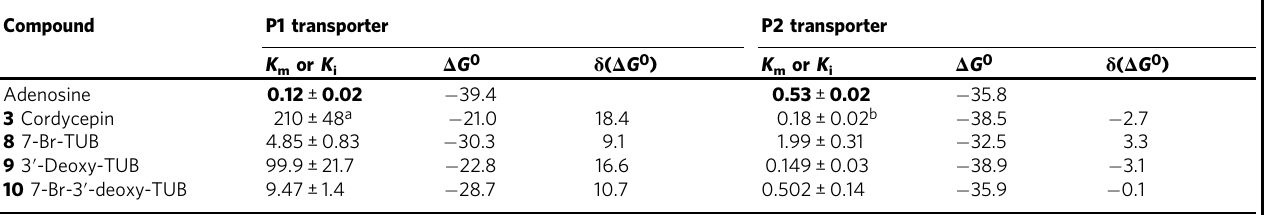
K m (highlighted in bold) and K i values are in µ M; Δ G 0 in kJmol − 1 . K m and K i values are mean ± SEM, derived from three independent experiments ( n = 3) with three replicates. δ ( Δ G 0 ) was calculated in comparison to adenosine. Source data are provided as a Source Data fi le. a Value was taken from ref. 29 b Value was taken from ref. 18